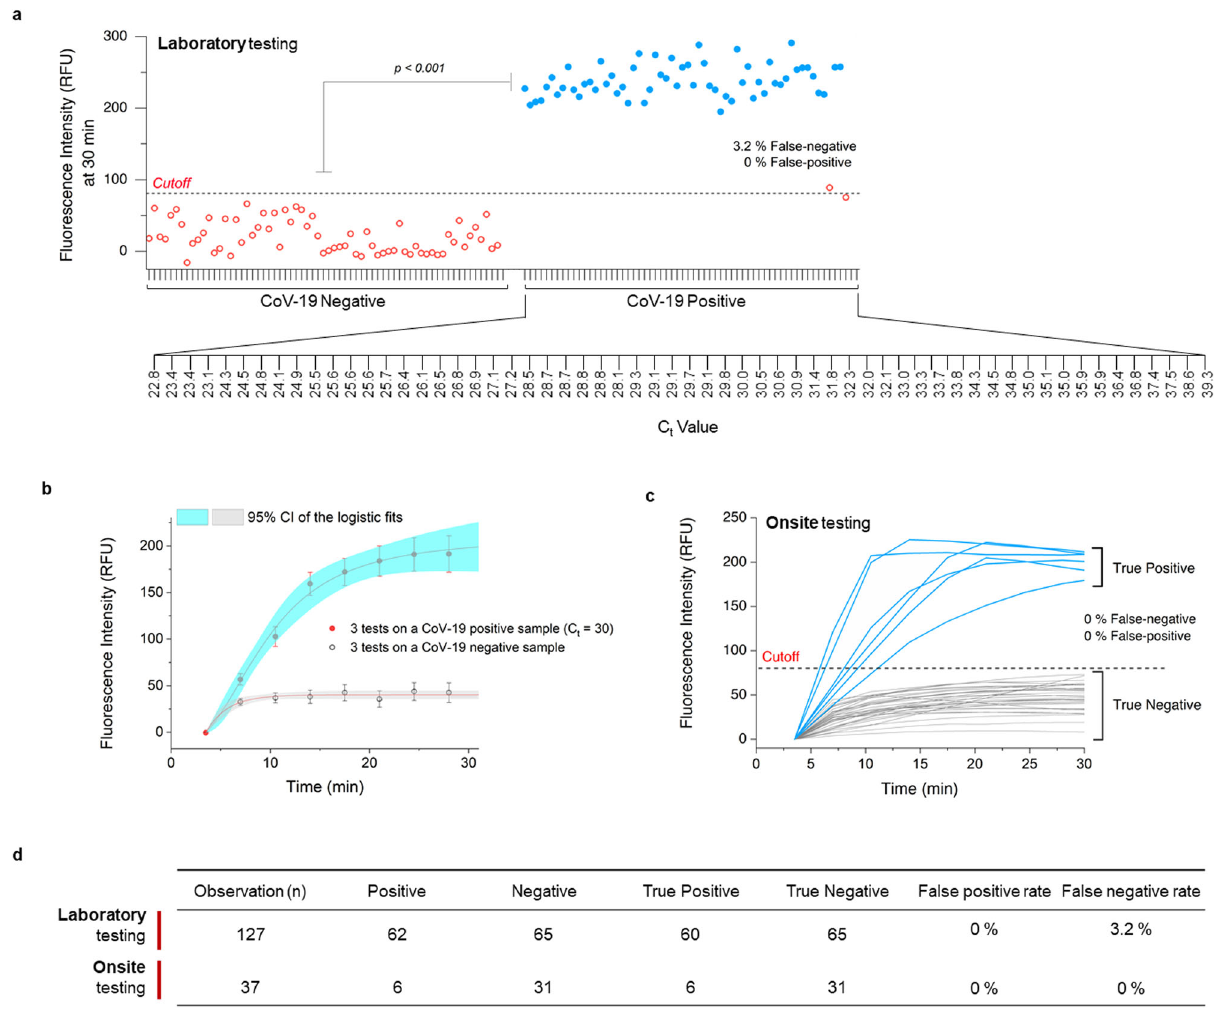
Fig. 6 Clinical validation of NISDA assay in oropharyngeal RNA extract specimens. a Plotting the NISDA assay data points obtained in the laboratory for 127 clinical oropharyngeal RNA extracts (65 validated CoV-19 negatives and 62 validated CoV-19 positives) together with the corresponding C t values of the positive samples; blue solid circles indicate samples considered positive by NISDA and red hollow circles indicate samples considered negative by NISDA; mean value difference between the two populations was statistically signi fi cant ( P < 0.001; calculated based on the unpaired two-tailed t test). b Reproducibility test of the NISDA assay showing the fl uorescence kinetics of three identical measurements on a CoV-19-positive sample ( C t = 30). CI denotes for the con fi dence interval. Error bars represent mean ± SD. c On-site performance of the NISDA assay at Bispebjerg Hospital using Real-Time PCR System (CFX96) for monitoring the fl uorescence kinetics of 37 clinical oropharyngeal RNA extracts (31 validated CoV-19 negatives (gray solid lines under the cutoff value) and 6 validated CoV-19 positives (blue solid lines above the cutoff value)). d Numbers of false-negative and positive rates for two clinical validations in the laboratory and the hospital (on-site). Source data are provided as a source data fi le. Table 1 Characterization of NISDA assay performance in comparison with